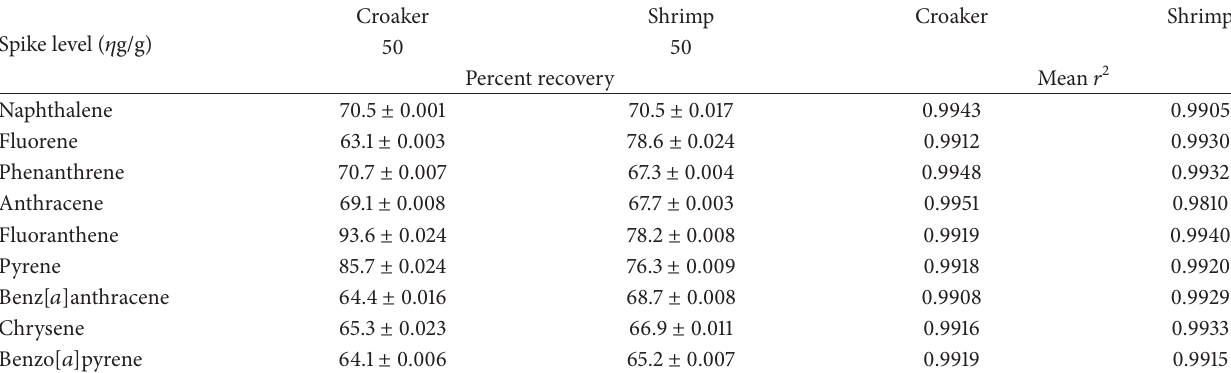
Table 5: Analysis of finfish and shrimp matrices, 𝑛 = 3